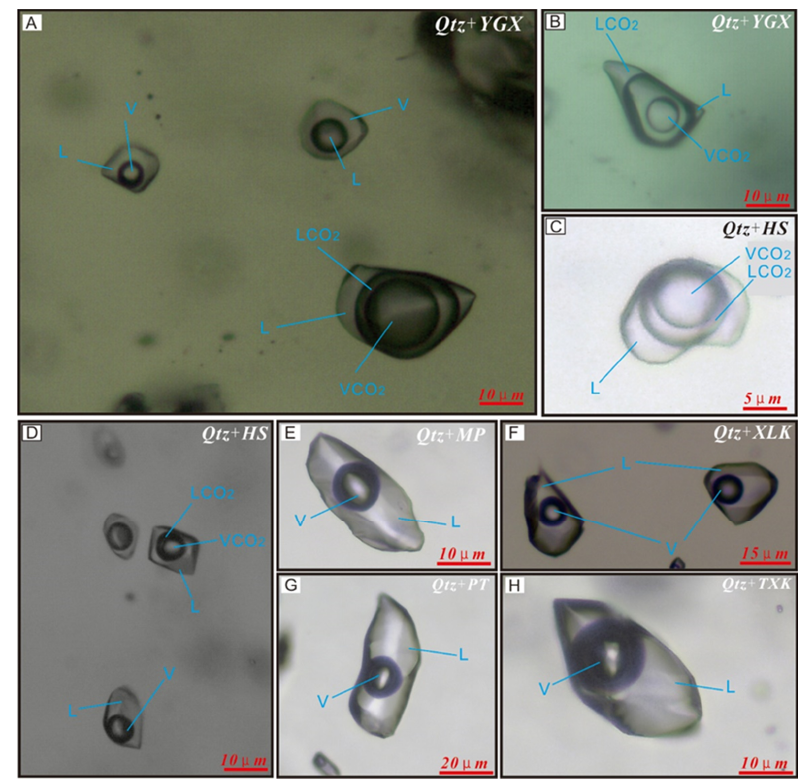
Figure 6. Representative fluid inclusions captured in quartz from wolframite-quartz vein-type tung- sten deposits in South China. CO 2 -bearing inclusion coexisting with liquid-rich aqueous inclusions in the Yaogangxian ( A ) and Huangsha tungsten deposit ( D ). ( B ) Typical three-phase fluid inclusions in quartz generally consist of liquid CO 2 , gas CO 2 and a small amount of aqueous solution, respec- tively (the Yaogangxian tungsten deposit). ( C ) CO 2 -bearing inclusion in the Huangsha tungsten deposit. ( E – H ) Two-phase aqueous inclusions in the Maoping ( E ), Xingluokeng ( F ), Piaotang ( G ) and Taoxikeng ( H ) tungsten deposits, respectively. Abbreviations: Qtz—Quartz; YGX—Yaogangxian;